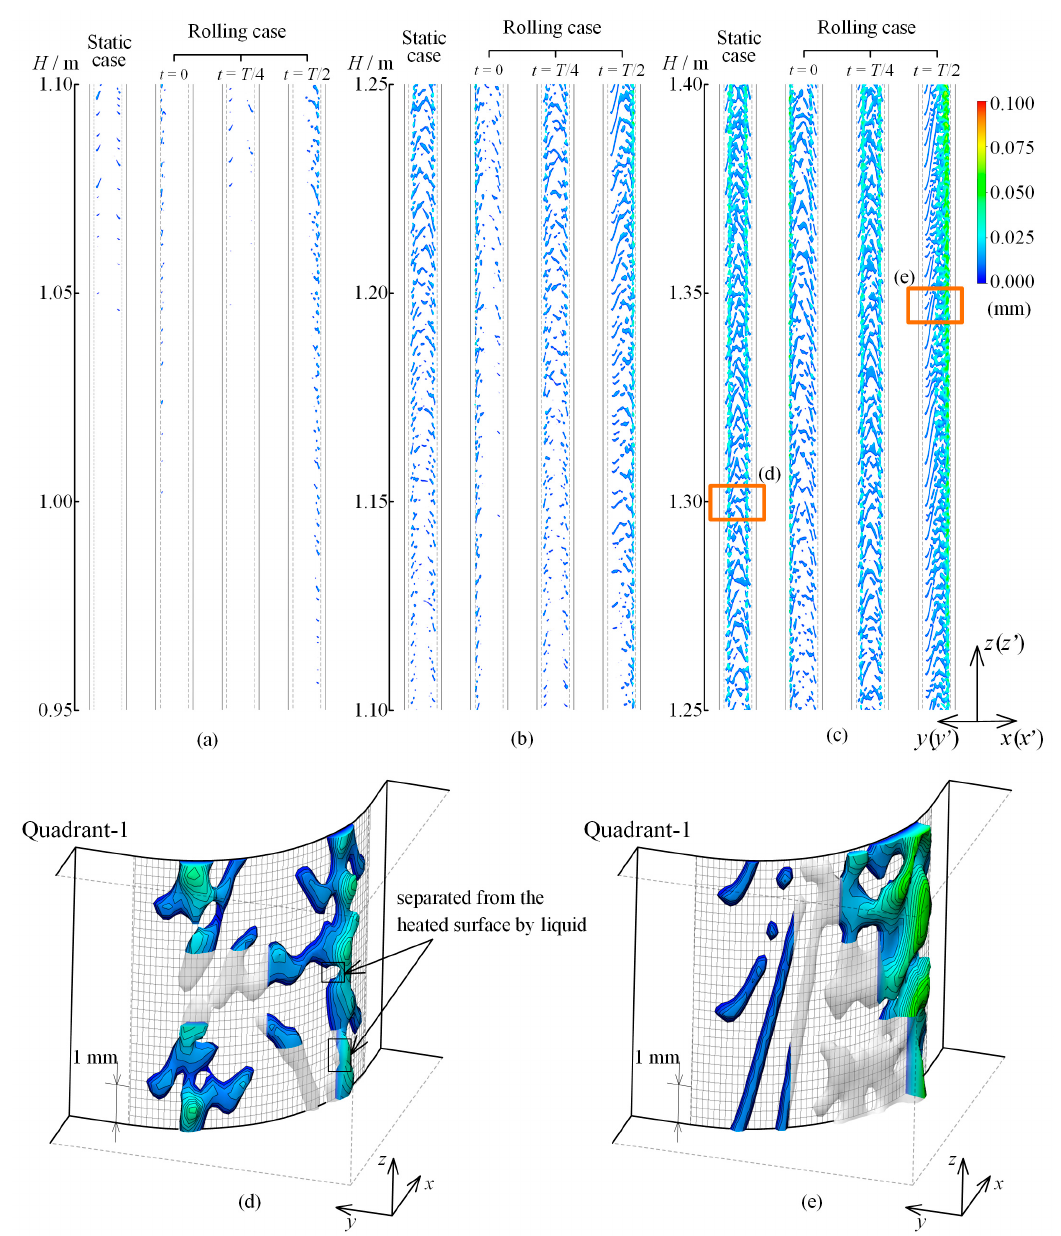
Figure 8. Vapor–liquid phase distribution in Quadrant-1: ( a ) 0.95–1.10 m; ( b ) 1.10–1.25 m; ( c ) 1.25–1.40 m. ( d ) A detail of the static case; ( e ) a detail of the rolling case.